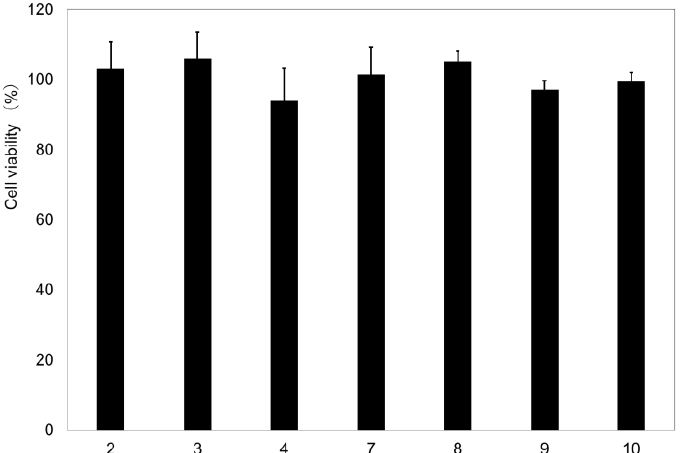
Figure 3. Cytotoxicity of extracts. n = 3. Sample concentration: 25 µ g/mL; CSL: Coriander; FN: Fennel. The bars represent the mean + SD.